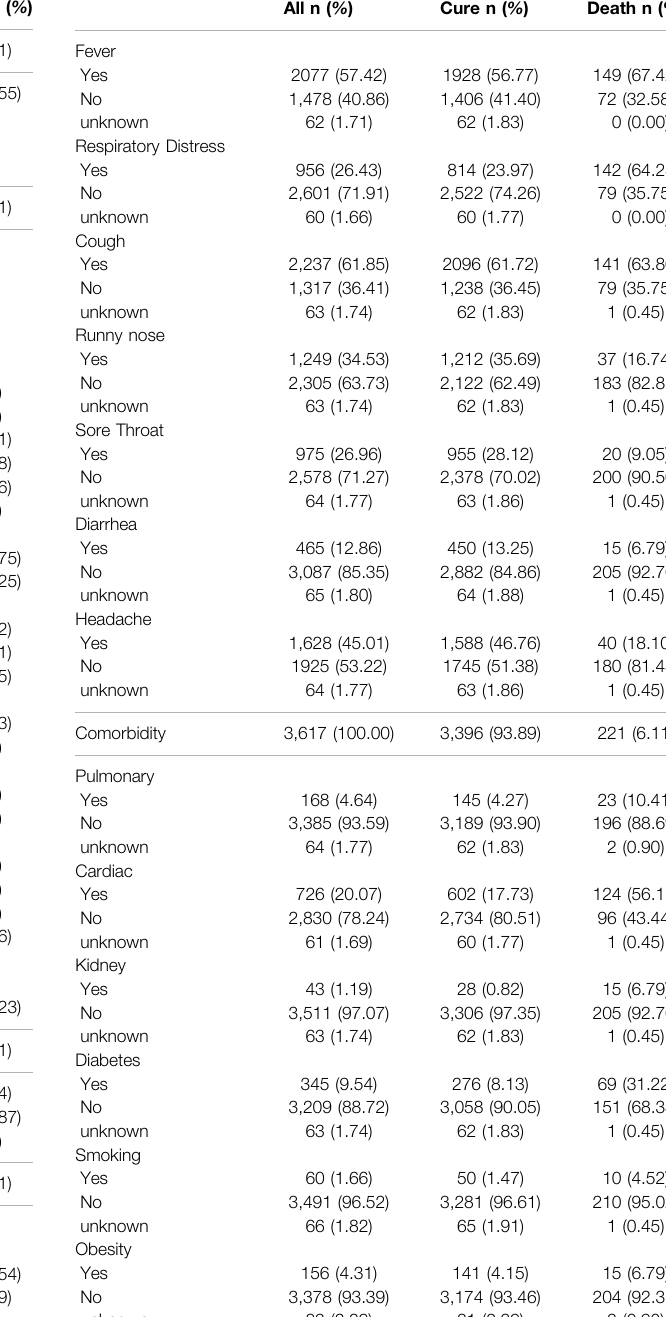
TABLE 2 | ( Continued ) Demographic data and clinical characteristics of the study populationValidation Dataset (May 24th - May